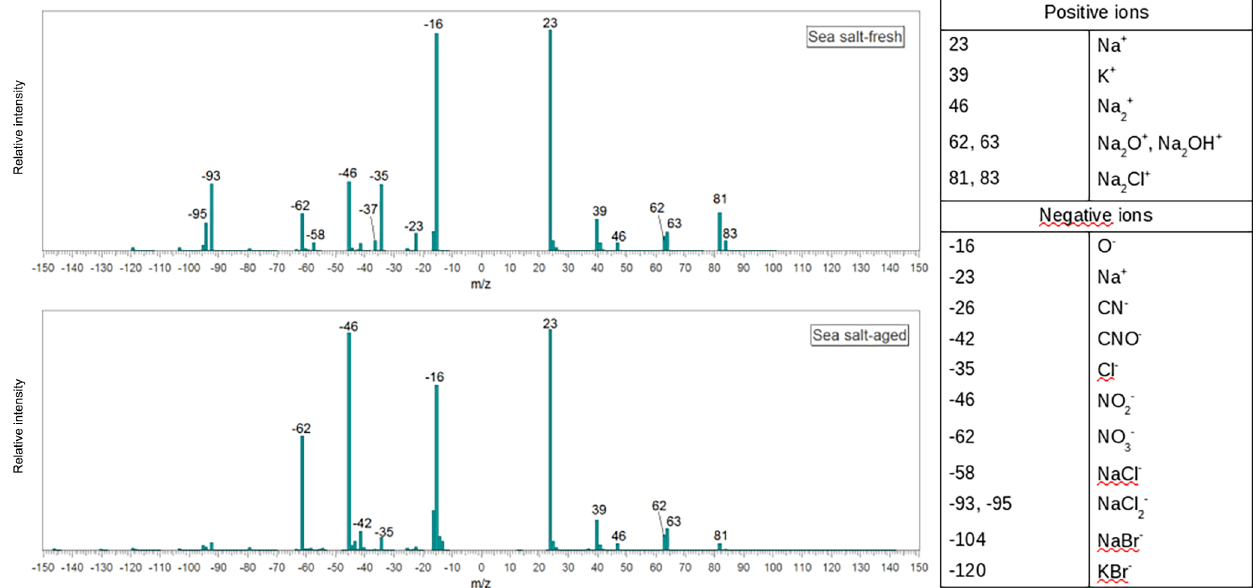
Figure 1. Average mass spectra for fresh and aged sea salt particles observed during ADRIMED.